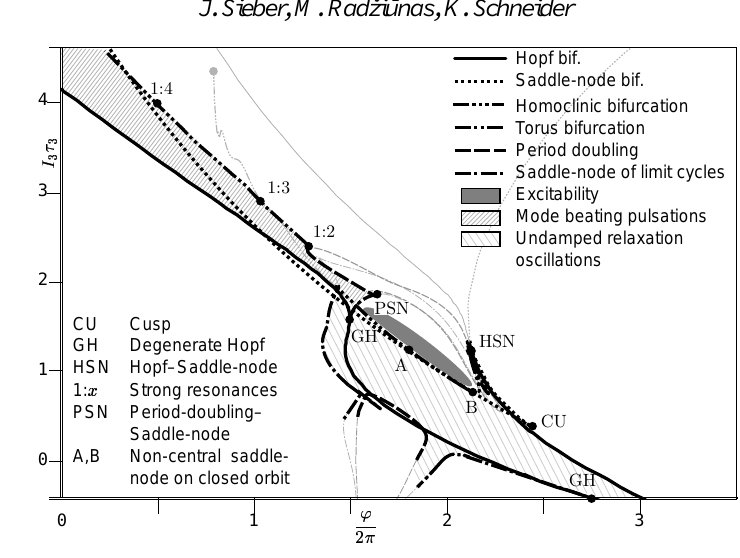
Figure 2. Bifurcation diagram for the two-mode approximation (truncated (6.1) with q = 2 ) in the parameter plane ( ’; I 3 ) (see [7] for the particular parameter